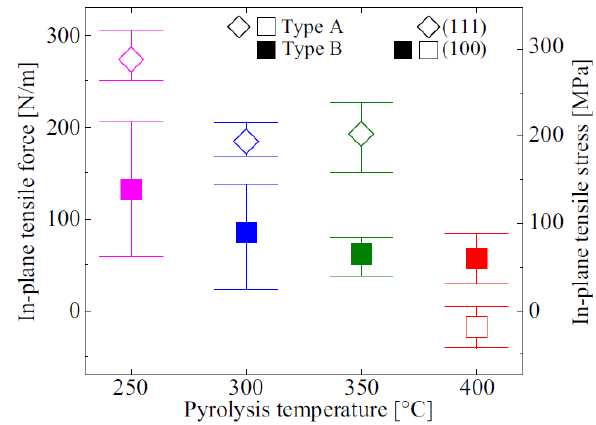
Figure 3. In-plane tensile force and stress of the prepared PZT films on